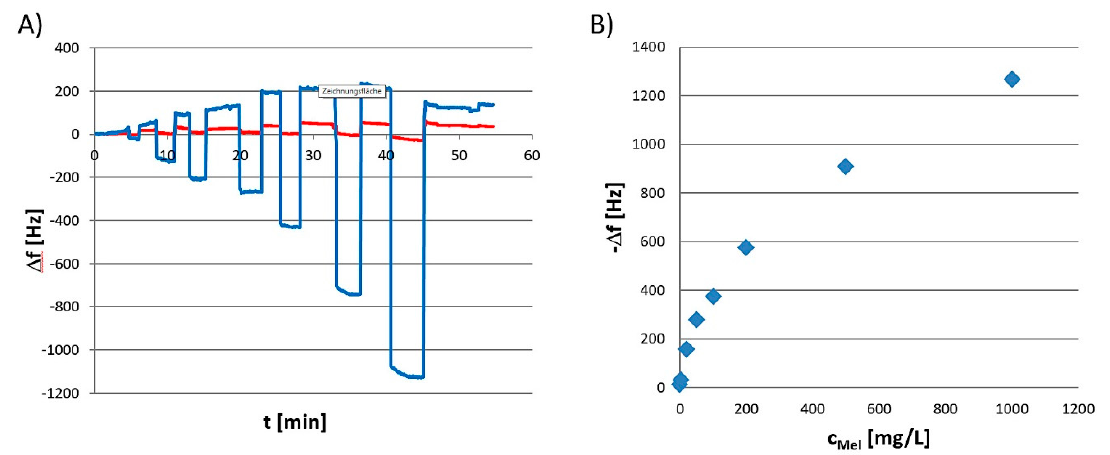
Figure 2. Sensor characterization of a melamine-imprinted sensor. ( A ) Sensor response pattern of dual-electrode QCM coated with MIP and NIP, respectively, when subjected to a number of different analyte concentrations ranging from 2–3200 mg/mL; ( B ) Corresponding sensor characteristic.